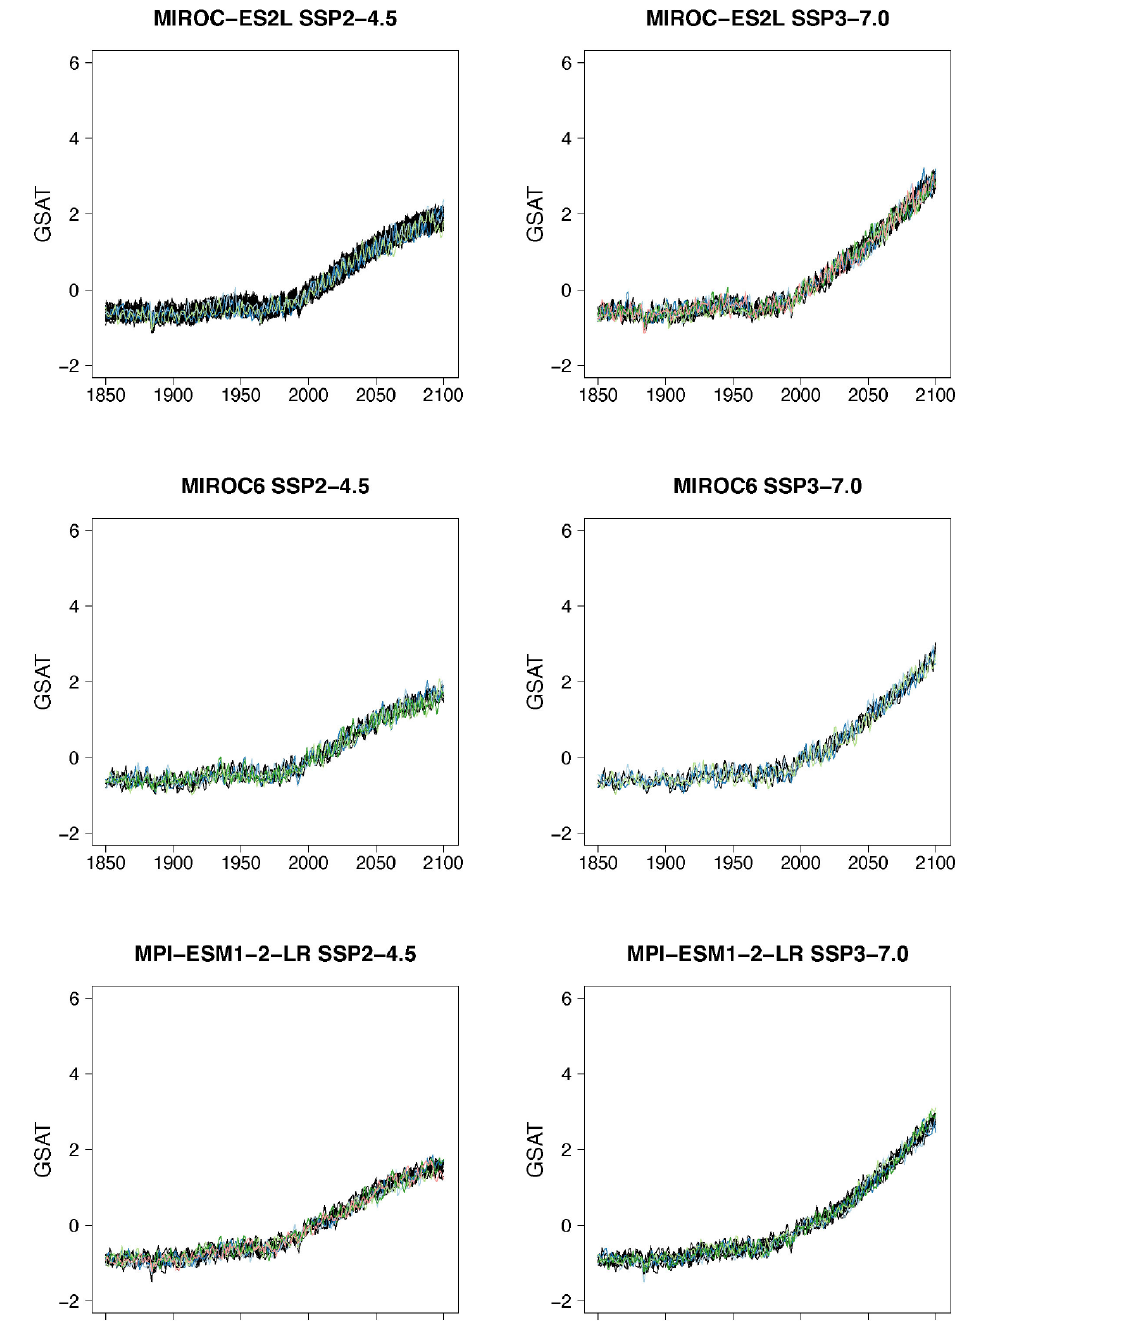
Figure B1. Examples of target (black lines) and stitched (colored) GSAT time series for ESMs in the PANGEO archive that ran at least one trajectory along the Tier 1 experiments of ScenarioMIP (SSP1-2.6, SSP2-4.5, SSP3-7.0, SSP5-8.5). We use the two bracketing scenarios and emulate trajectories that follow the two intermediate